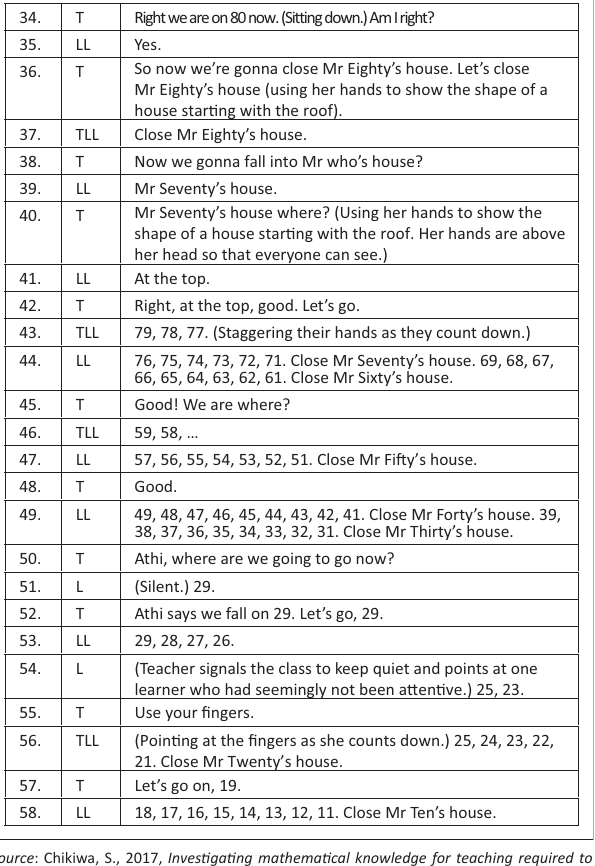
FIGURE 2: Excerpt showing the challenges learners face in bridging the decuples while counting back. T, Teacher; L, learner; LL, learners; TLL, teacher and